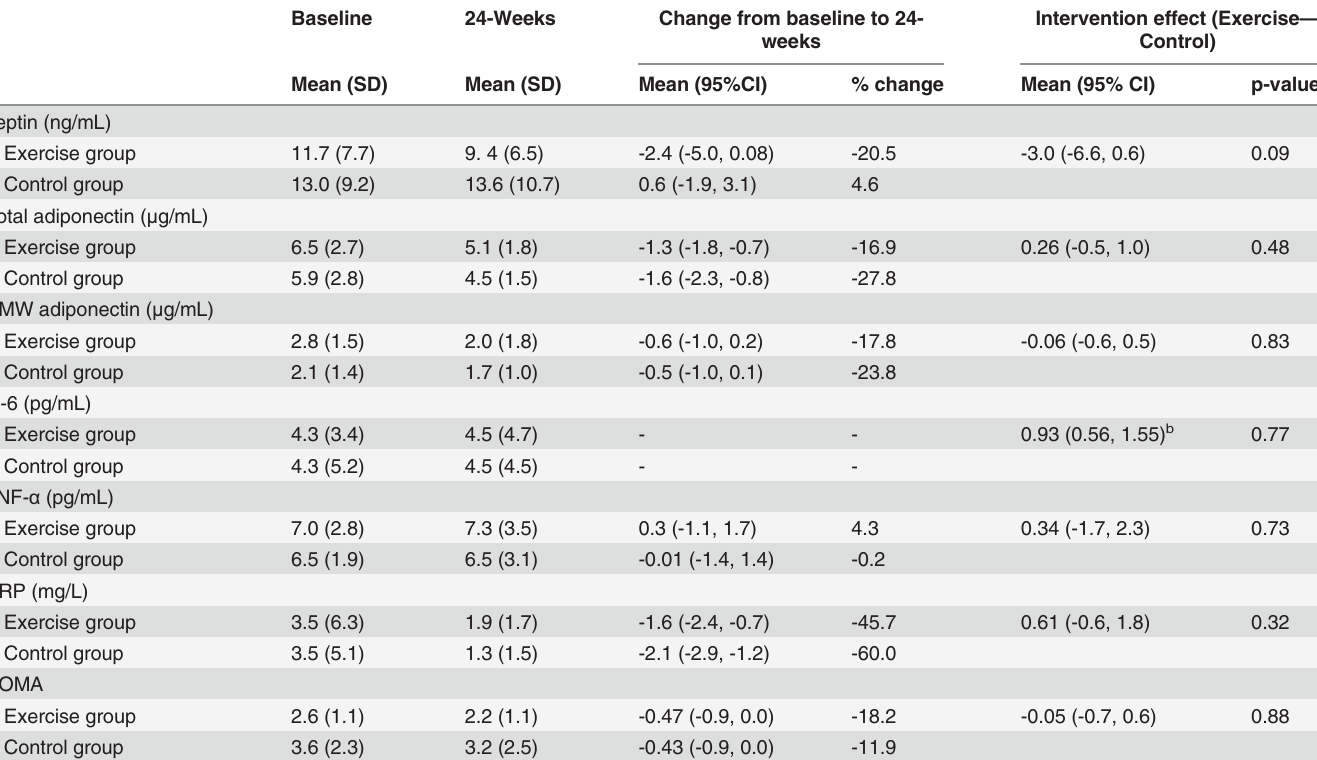
Table 2. Obesity-related hormone outcomes at baseline and week-24 comparing participants in the exercise group (n = 15) and control group (n = 15).